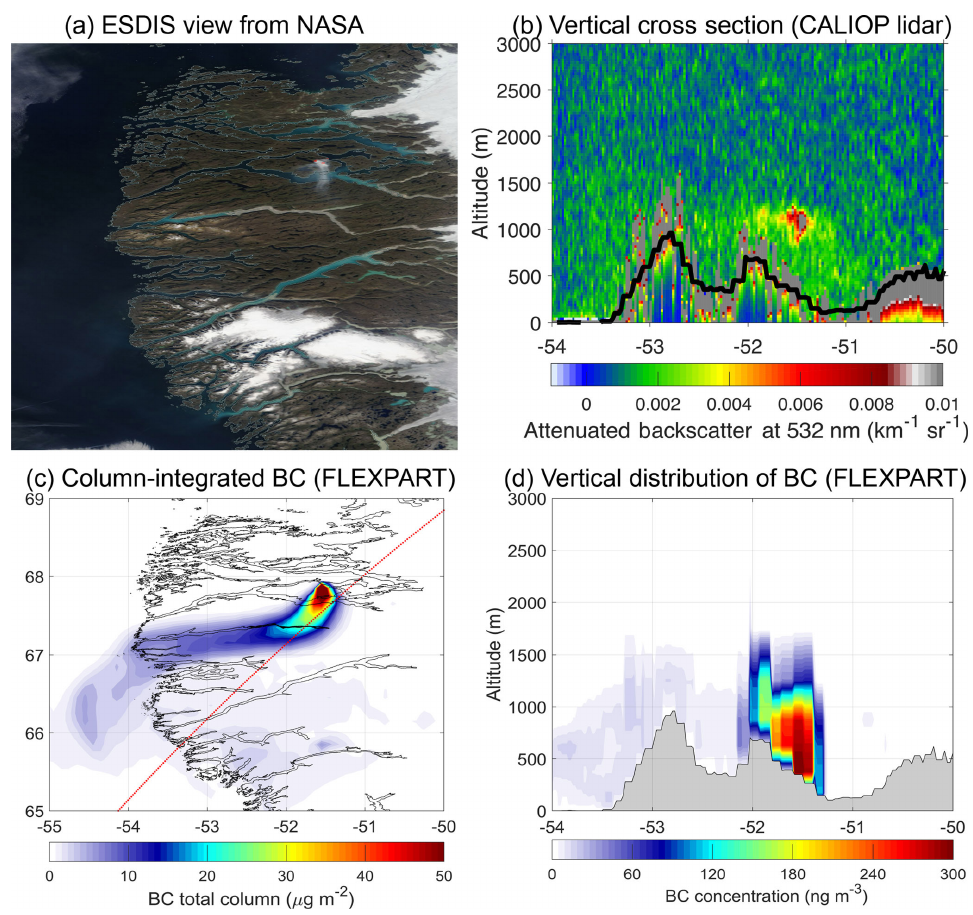
Figure 6. (a) Worldview application from the NASA Goddard Space Flight Center Earth Science Data and Information System (EOSDIS) project on 14 August 2017. (b) Vertical cross section along satellite’s route (red line in c ) of total attenuated backscatter at a wavelength of 532nm obtained from the CALIOP lidar on 14 August 2017 at 06:00UTC (black line denotes the orography of the area). (c) Column- integrated BC concentration simulated with FLEXPART (red line shows the path of the satellite). (d) Vertical distribution of BC concentra- tions with longitude as seen with FLEXPART (grey area denotes the orography of the